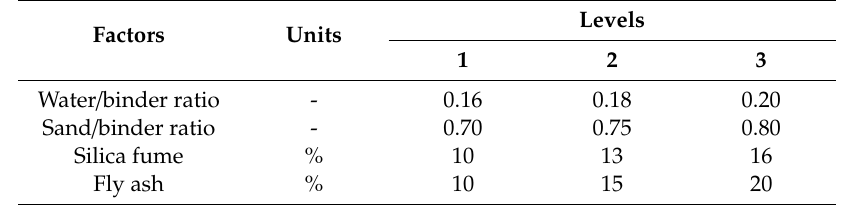
Table 7. Factor level.